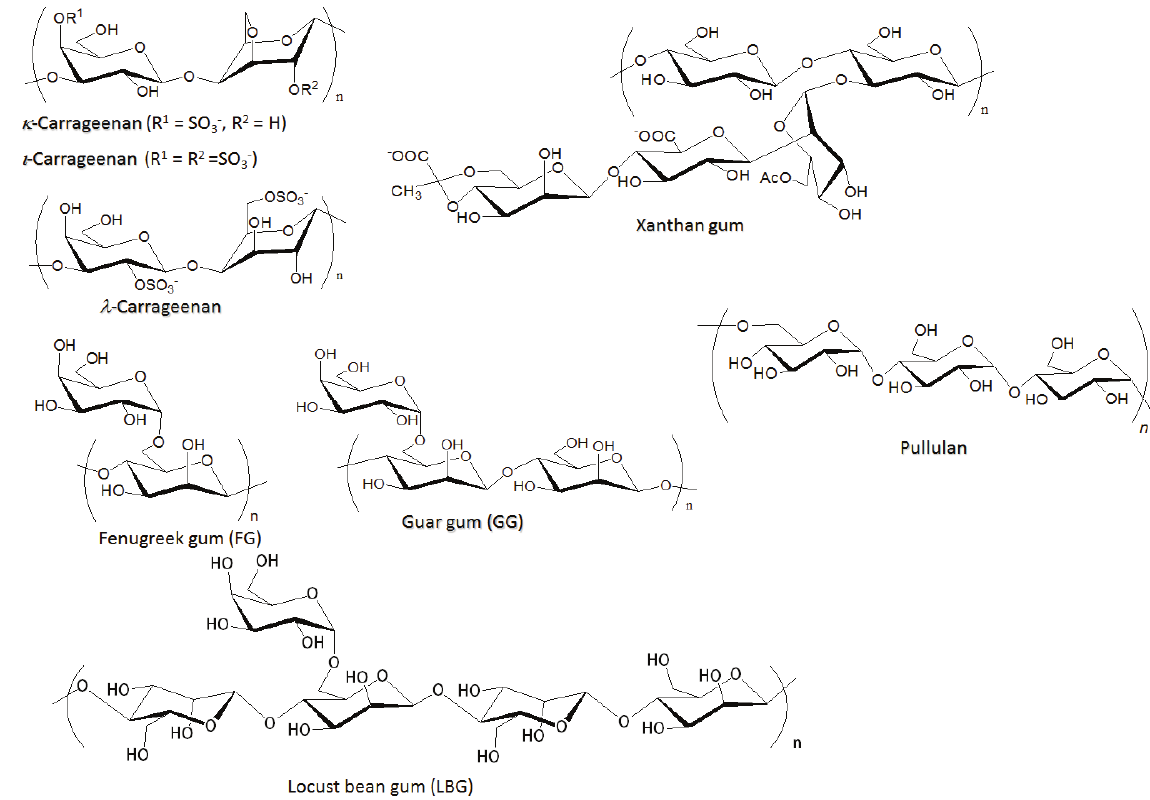
Figure 2. Structures of hydrocolloid polysaccharides, which are used in the fabrication of ion